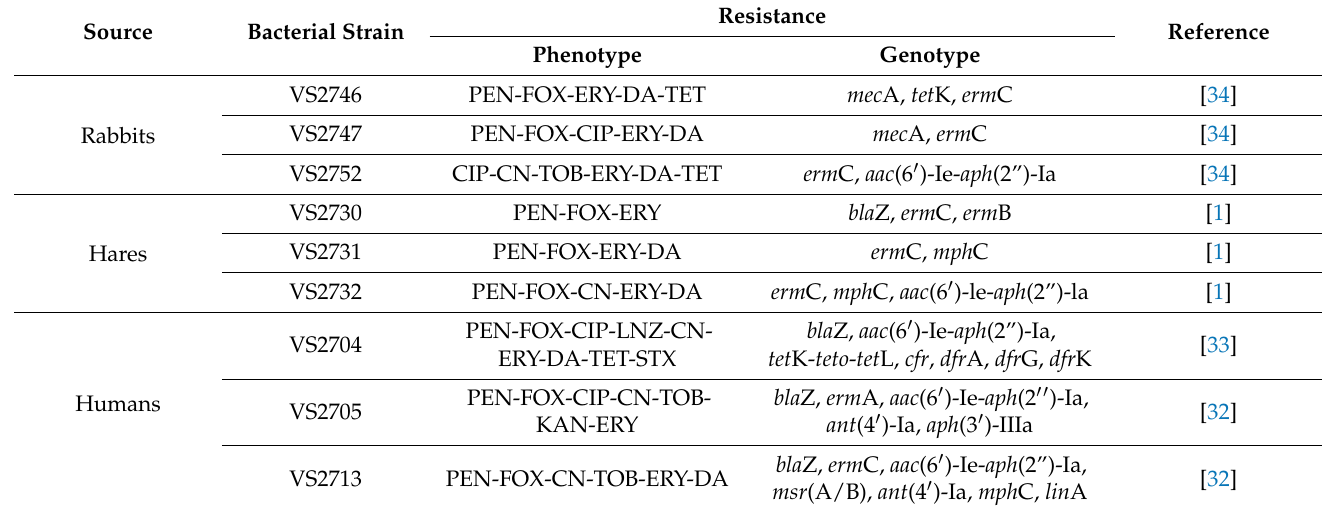
Table 1. Characteristics of the MRSA strains isolated from three different